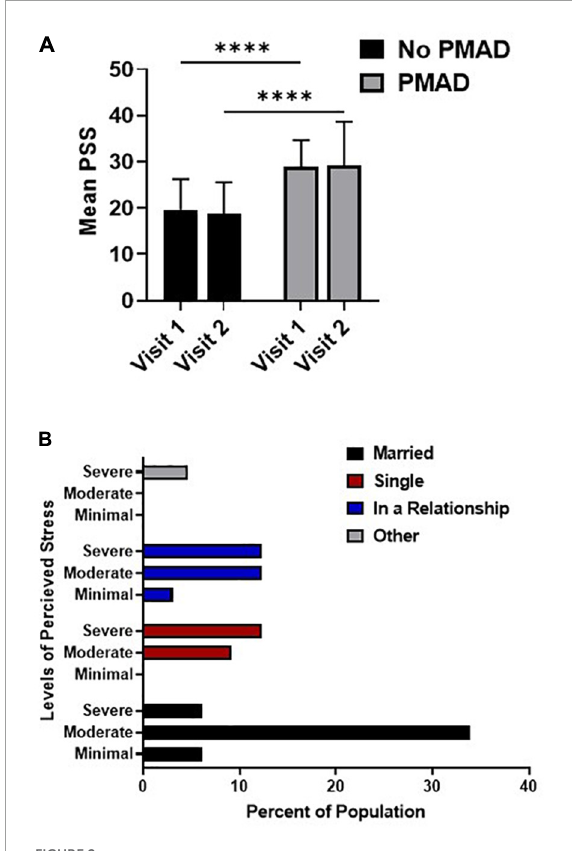
FIGURE2 Relationship between perceived stress and PMAD showed significance at both visits (A) while the association of relationship status and PSS was analyzed in (B) . ∗∗∗∗ Denotes p < 0.00005. PMAD, Perinatal mood and anxiety disorders; PSS, Perceived stress